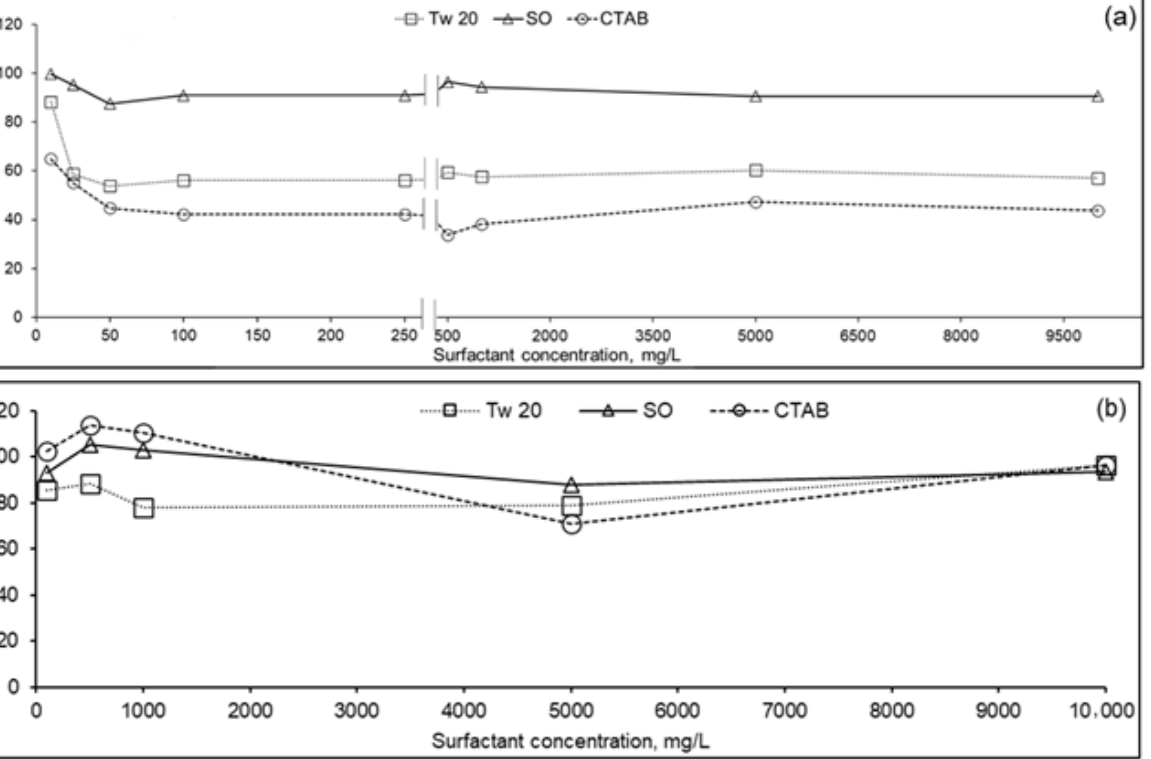
Figure 4. Relative flux ( RF ) of RO membrane as function of surfactant concentration of PA ( a ) and CA ( b ) membranes (10% recovery ratio, TMP = 1.5 MPa, T = 25 °C). Relative flux of CA membrane versus surfactant concentration is plotted in Figure 4b. For different surfactants and at concentration range 100–10,000 mg/L, relative fluxes